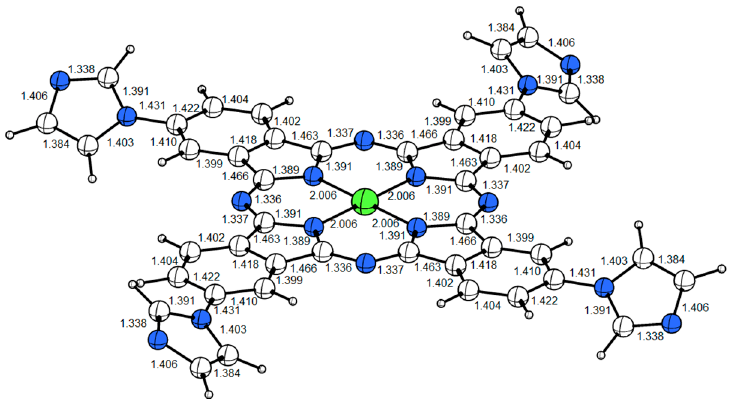
Figure 2. The planar structure of the palladium phthalocyanine PdPc molecule. The Pd and N atoms are respectively labeled in green and blue. The Pd–N bond length of the optimized structure is 2.006 Å.